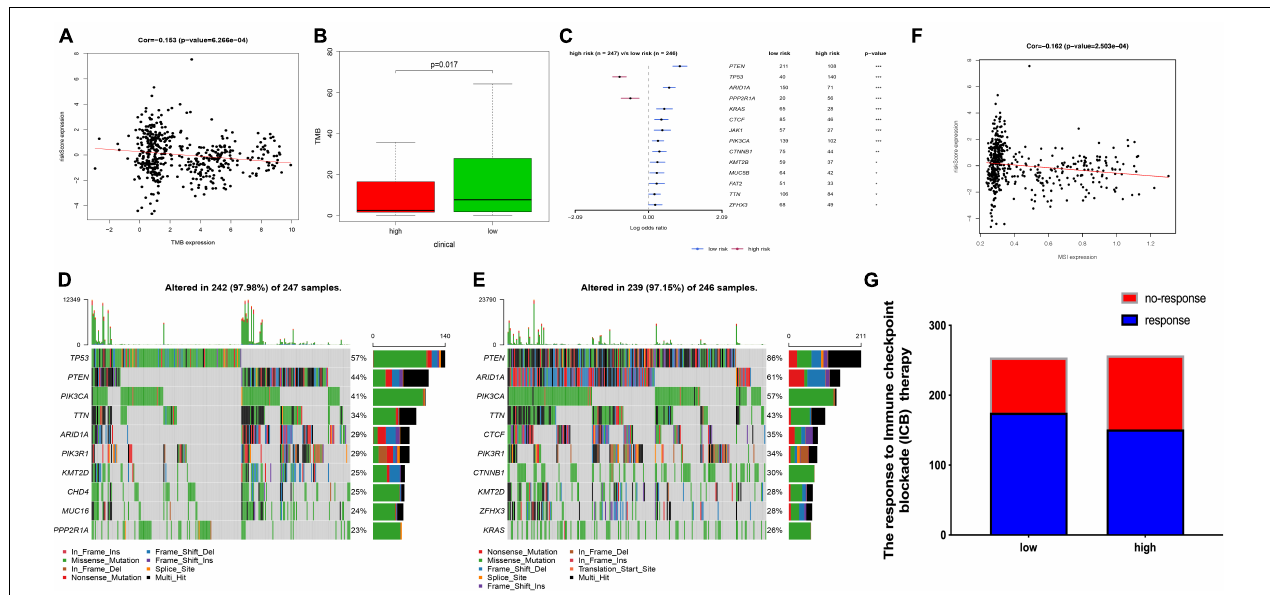
FIGURE 8 | The TMB, mutation profile, and MSI in high-risk and low-risk groups. (A) The correlation between TMB and FRPS. (B) The TMB status in high-risk and low-risk groups. (C) The most frequently mutated genes in high-risk and low-risk groups. (D,E) The top 10 mutated genes in high-risk and low-risk groups. (F) The relationship between MSI and FRPS. (G) The rate of response to immunotherapy in high-risk and low-risk groups. Red line to provide a brief tendency of association between TMB, MIS and riskscore. * P < 0.05, ** P < 0.01, *** P <